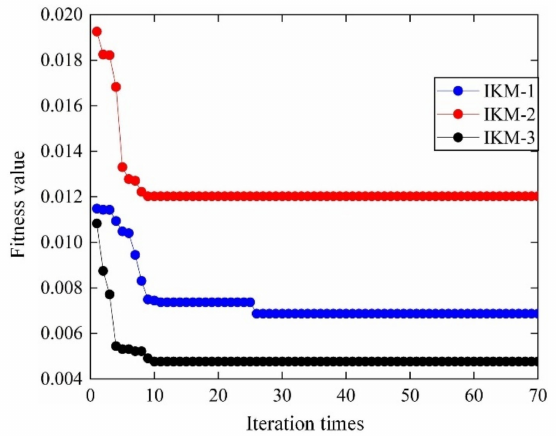
Figure 8. DMIGA optimization process of decomposed IKM.